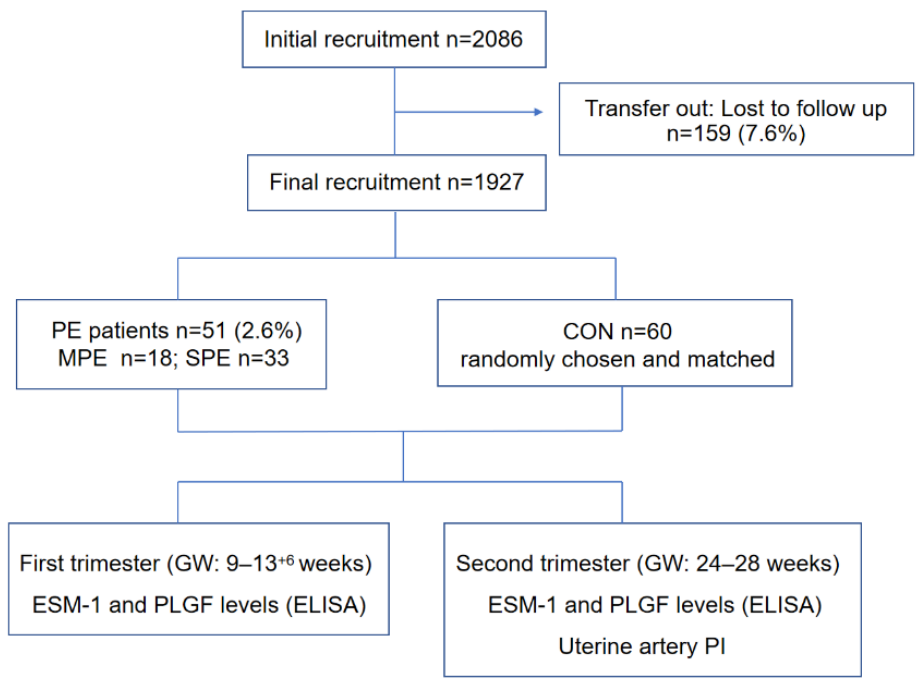
Figure 1. The flowchart of the prospective cohort study. CON, control group; MPE, mild preeclampsia group; SPE, severe preeclampsia group; GW, gestational week. Table 1. Demographic characteristics of the